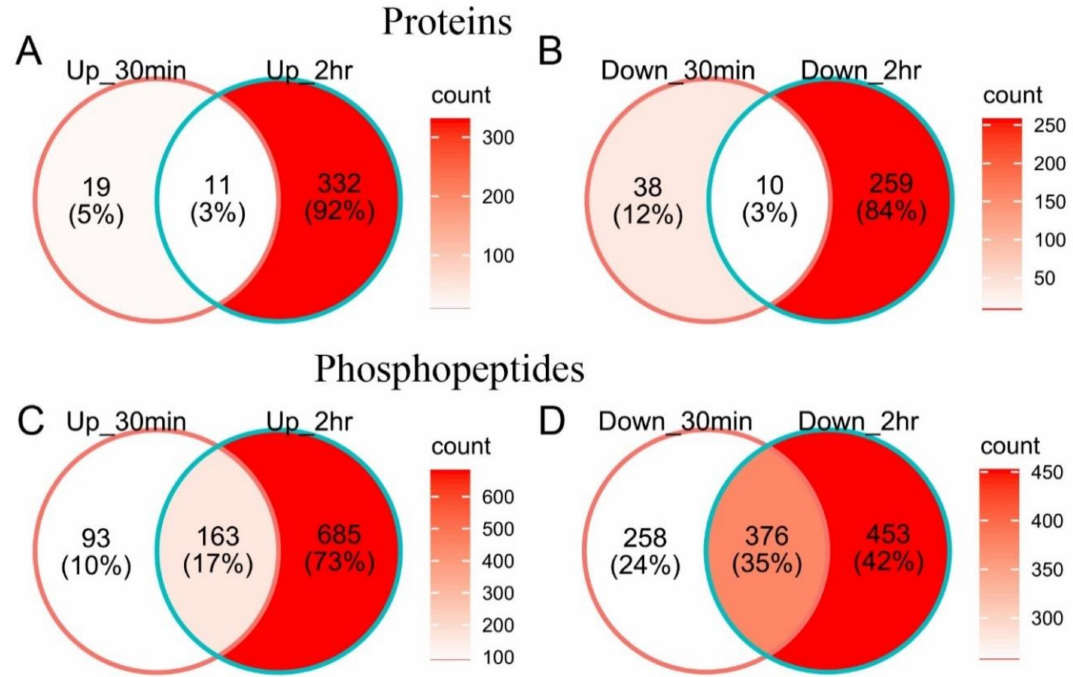
Figure 4. Venn diagram showing numbers of cold-responsive proteins ( A , B ) and phosphopeptides ( C , D ) of maize seedlings under different cold-shock durations (30 min and 2 h). Numbers of up- regulated ( A , C ) and down-regulated ( B , D ) ones were listed separately. Color in each region is coded according to the count of observations contained